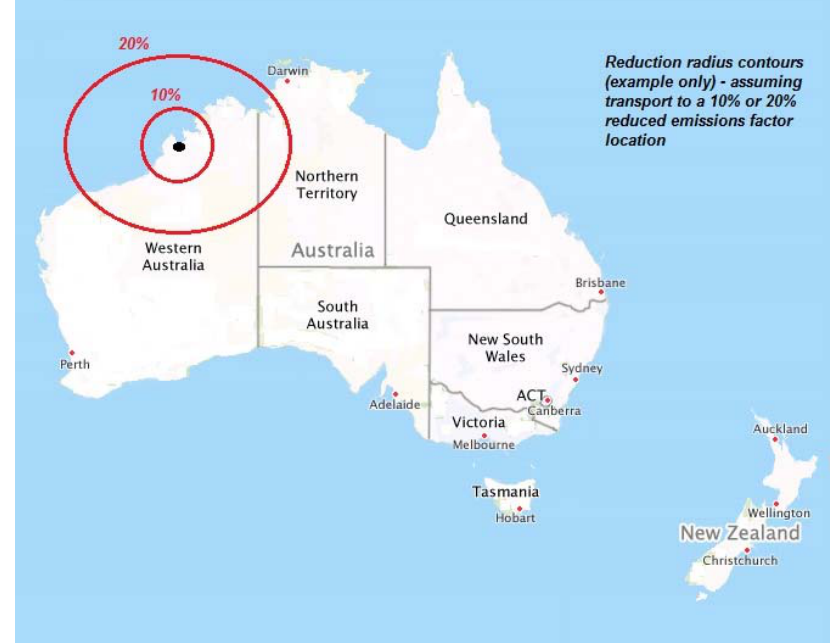
Figure 1. Example reduction radius contour